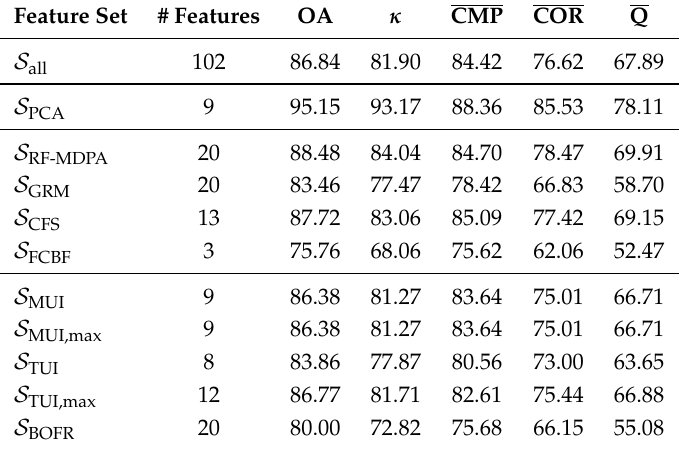
Table 2. Classification results (in %) derived with the Random Forest (RF) classifier for the Pavia Centre dataset (9 classes).